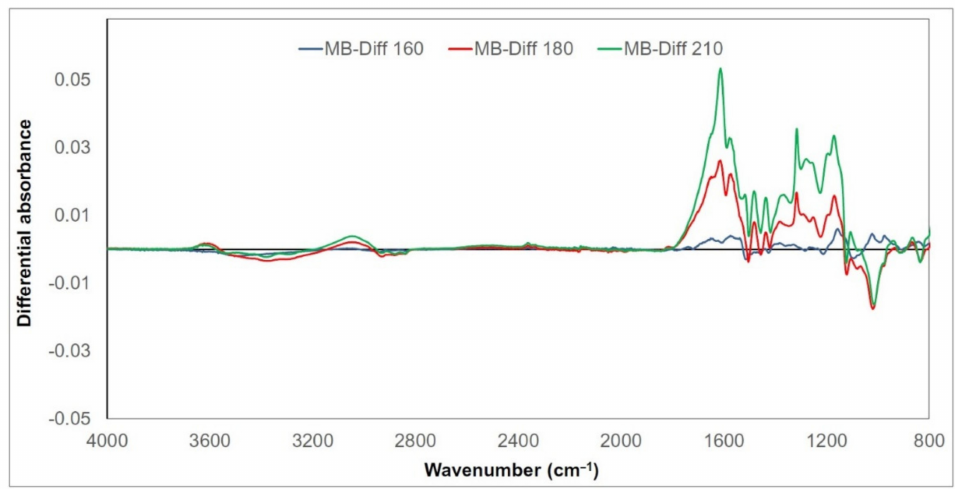
Figure 6. Differential FTIR spectra of thermally treated merbau wood